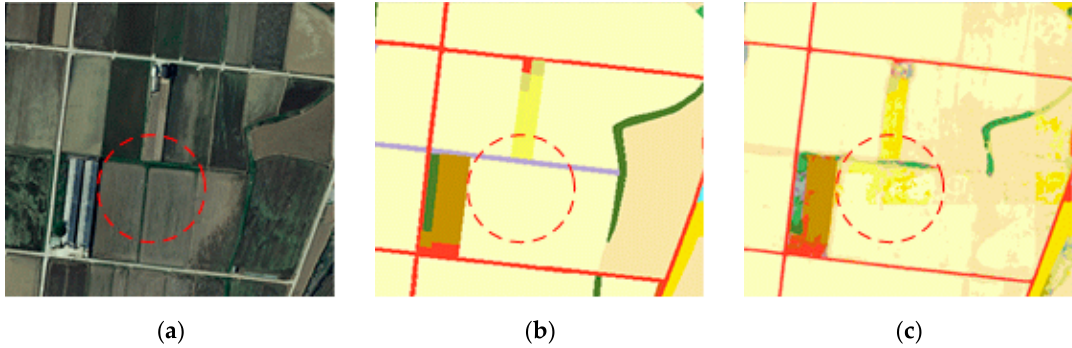
Figure 12. Example of ambiguity of boundaries (bright and dark skin color are paddy field, bright and dark yellow are upland). ( a ) Orthographic image, ( b ) Land cover map, ( c ) Classification result.